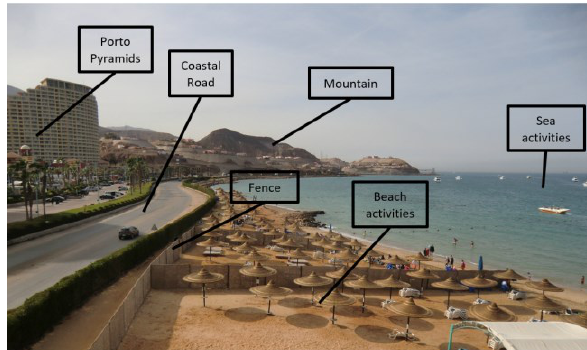
Figure 5. Porto Sukhna beach. (Source: